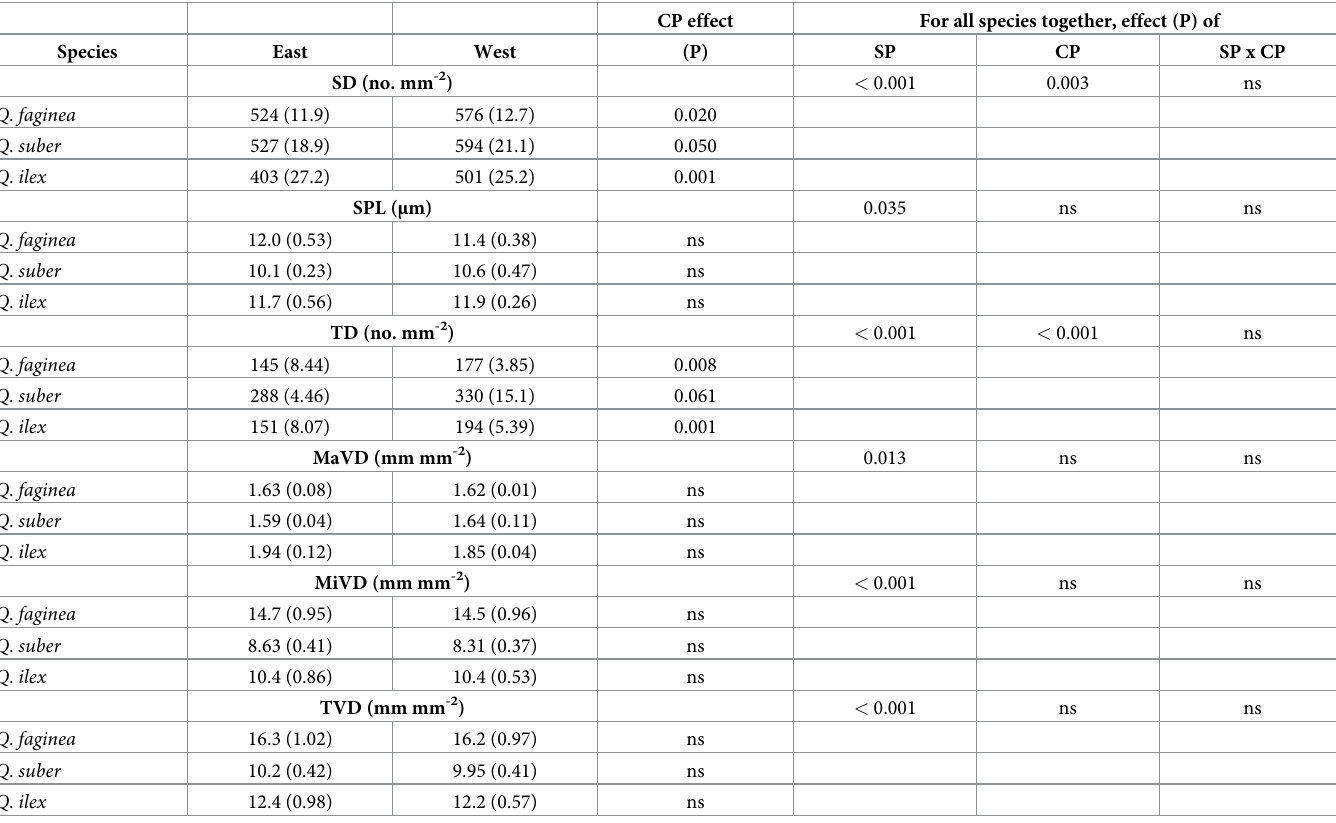
Table 3. Average stomatal and venation traits and trichome density at two canopy orientations (S.E. in parentheses, n = 5 trees) for three tree species. Results of analyses of variance for individual species in tests for effect of canopy position (CP) and for all species together in tests for species differences (SP), effect of canopy position (CP) and species x canopy position (SP x